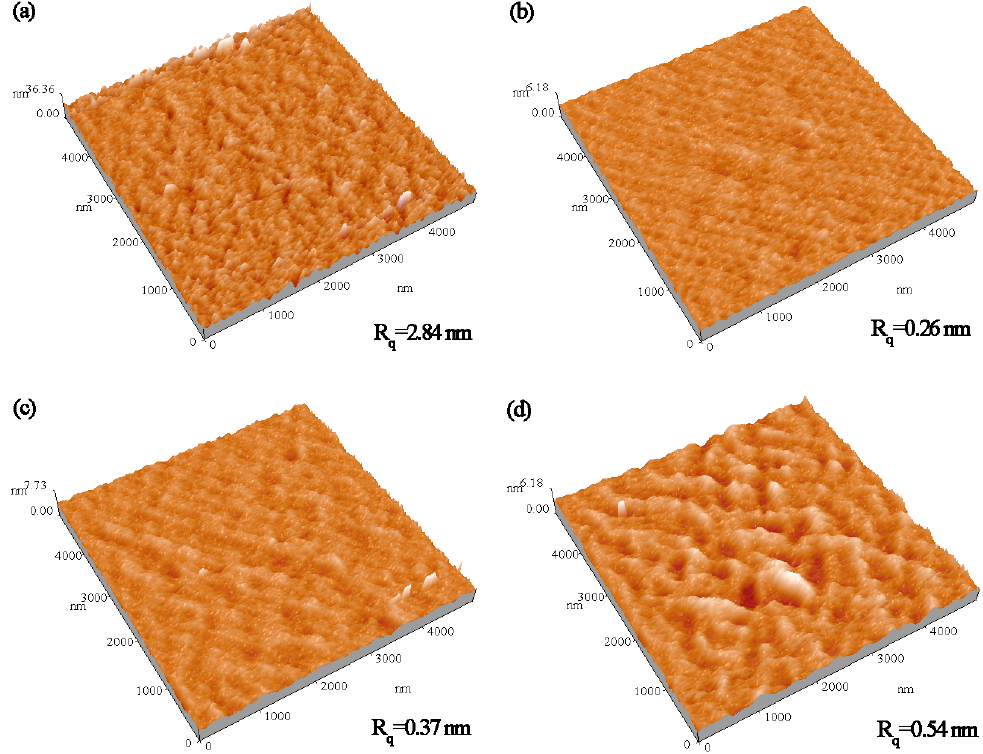
Figure 8. AFM images of ( a ) bottom layer T33S67, ( b ) middle layer Nb 2 O 5 , ( c ) top layer SiO 2 and ( d ) triple-layer AR coating.